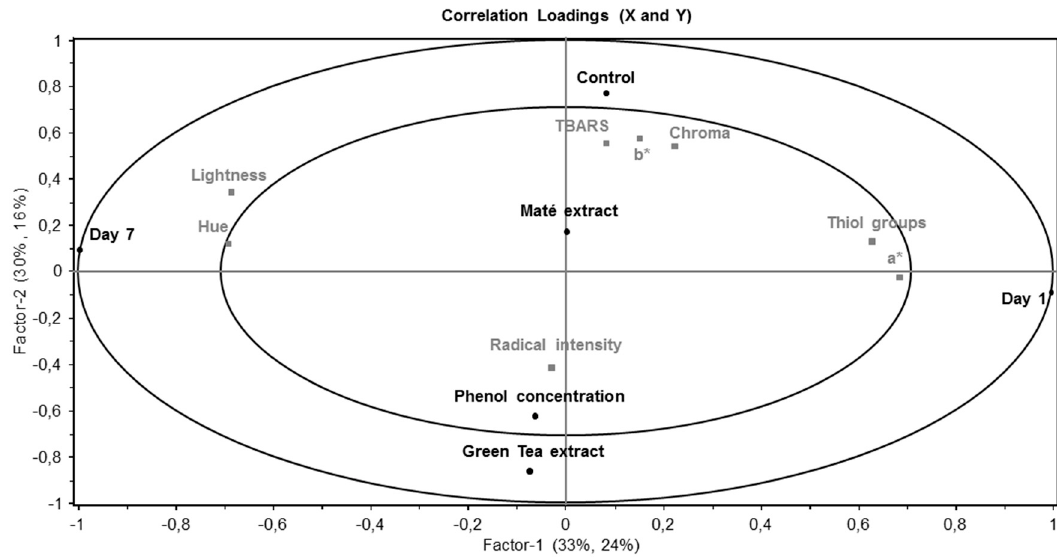
Figure 1. Oxidation parameters presented as a PLSR correlation loadings plot for PC1 versus PC2 of pork chops injected with three different concentrations of green tea or maté extract (25–180 ppm gallic acid equivalents), and chill stored in high-oxygen modified atmosphere packaging (MAP) for 1 or 7 days. The model was derived from treatment variables (injection brine [Control, Green tea, or maté extract], phenol concentration, and day) in the X-matrix, and color parameters and oxidation parameters in the Y-matrix. Ellipses represent r 2 = 0.5 and 1.0.